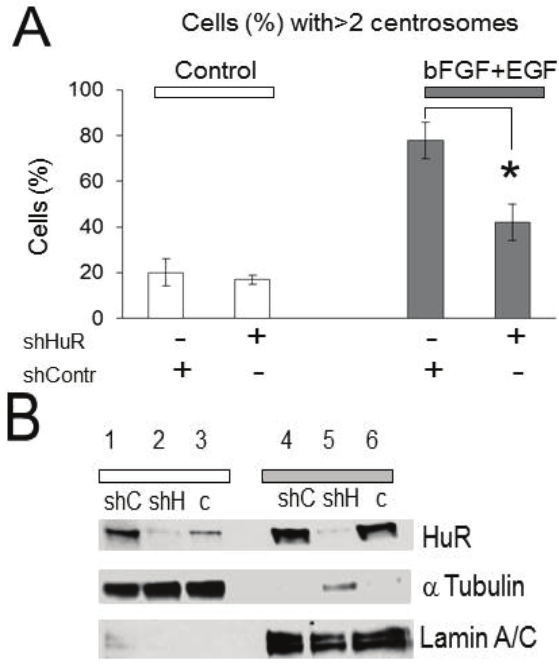
Figure 2. Knockdown of HuR diminishes centrosome amplification evoked by growth factors. ( A ) The graph represents the averaged percentages of cells with amplified centrosome number before and after HuR knockdown in the control condition and following stimulation with growth factors (20% ± 6% and 17% ± 2% ( n = 3) versus 76% ± 8% and 42% ± 8% ( n = 3)) in control and growth factors stimulated conditions, respectively. centrosome number in growth factor treated condition ( p = 0.01), ( B ) Illustration of HuR knockdown in the cytoplasmic and nuclear fractions detected in Western blot. Lines 1 and 4 correspond to sh-control (shC), lines 2 and 5 correspond to sh-HuR (shH), and lines 3 and 6 correspond to non-transfected ( C ) conditions. The (cid:3)-tubulin and lamin A/C mark cytoplasmic and nuclear fractions,